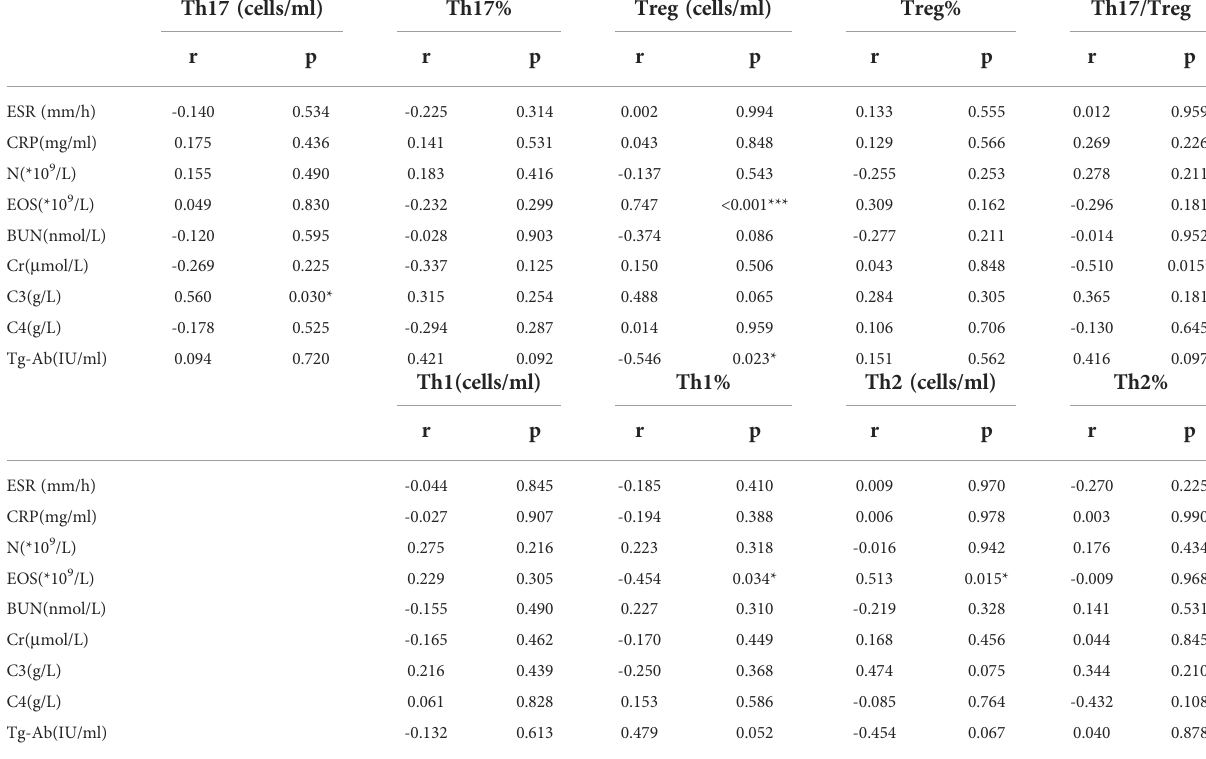
TABLE 4 Correlation